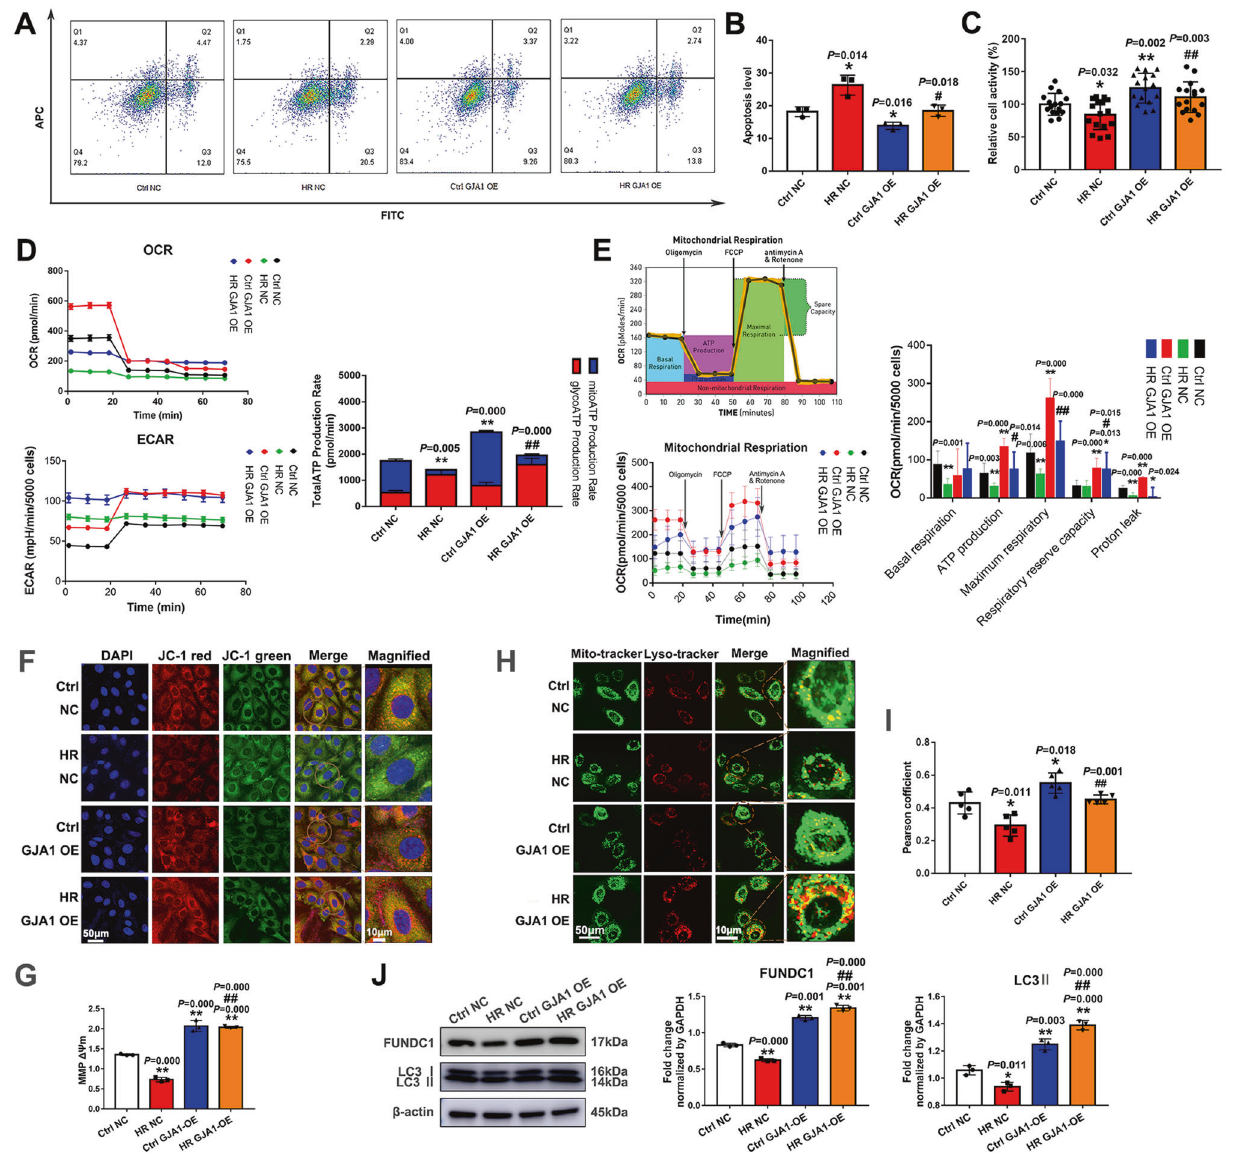
Fig. 6 GJA1 protected myocardial cells by decreasing cell apoptosis, enhancing cell viability & ATP production rate & oxidative phosphorylation, protecting mitochondrial membrane potential & activating mitophagy. A, B Apoptosis in H9c2 cells was measured by Flow Cytometry under normoxia or HR conditions with GJA1 OE. n = 3 in each group. C Cell viability was determined by using a cell counting kit- 8 under normoxia or HR conditions with GJA1 OE and absorbance was measured at 450 nm. n = 16 in each group. Relative cell activity (%) = [(As-Ab)/(Ac-Ab)] ×100%. As: absorbance of the experimental group; Ab: absorbance of the blank group; Ac: absorbance of the Ctrl NC group. APC: allophycocyanin; FITC: Fluorescein Isothiocyanate. D Total ATP production rates were measured by Agilent Seahorse analyzer under normoxia or HR conditions. The ECAR and OCR were measured under basal conditions. By obtaining these data under basal conditions and after serial addition of Rotenone/antimycin A, total cellular ATP Production Rates could be measured in real-time. n = 10 in each group. The results of seahorse tests were normalized to the value per 5000 cells. E Mitochondrial respiration was measured including ATP production, maximal respiration, Proton leak, spare respiratory capacity, and basal respiration by Agilent Seahorse analyzer under normoxia or HR conditions. n = 10 in each group. The results of seahorse tests were normalized to the value per 5000 cells. FCCP: Carbonyl cyanide-4 (tri fl uoromethoxy) phenylhydrazone. F – G MMP was observed with JC-1 staining. Nuclei were stained with DAPI. The cells were observed by laser confocal microscopy. Fluorescence intensity was measured by ImageJ software. Scale bars, 50 μ m and 10 μ m in magni fi ed. n = 3 in each group. H The co- localization experiments to observe mitophagy activity. Cells were stained with mito-tracker (green) and lyso-tracker (red). Scale bars, 50 μ m and 10 μ m in magni fi ed. I The quantitative analysis of the co-localization of lysosome and mitochondria was assessed by the Pearson ’ s correlation coef fi cient. J The levels of FUNDC1-mediated mitophagy-associated proteins were assessed by Western blot. n = 3 in each group. Data were expressed as mean ± SD; Statistical signi fi cance by two-tailed Student ’ s t-test, * P < 0.05, ** P < 0.01 vs. Ctrl NC; # P < 0.05, ## P < 0.01 vs. HR